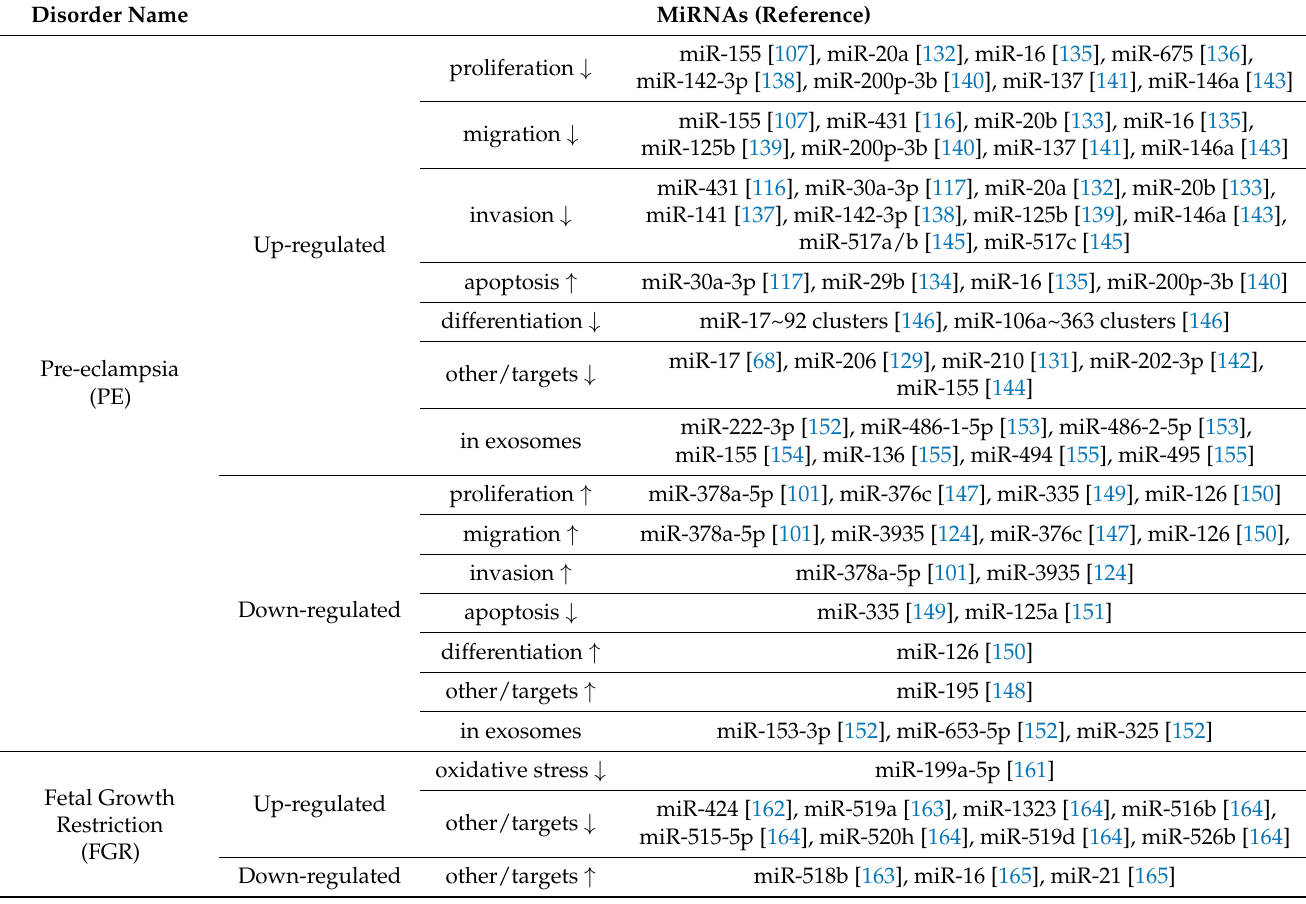
Table 2. Summary of aberrant expression of miRNA in human gestational